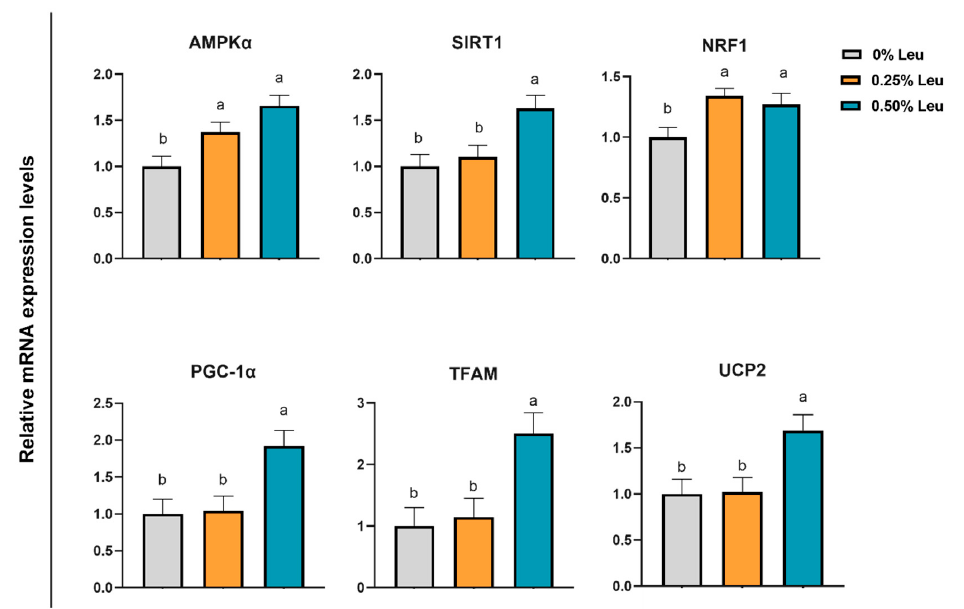
Figure 4. Relative mRNA expression levels of key genes related to mitochondrial function in longis- simus dorsi muscle. Leu: Leucine. a,b Different superscript letters on the same line are significant differences ( p < 0.05).